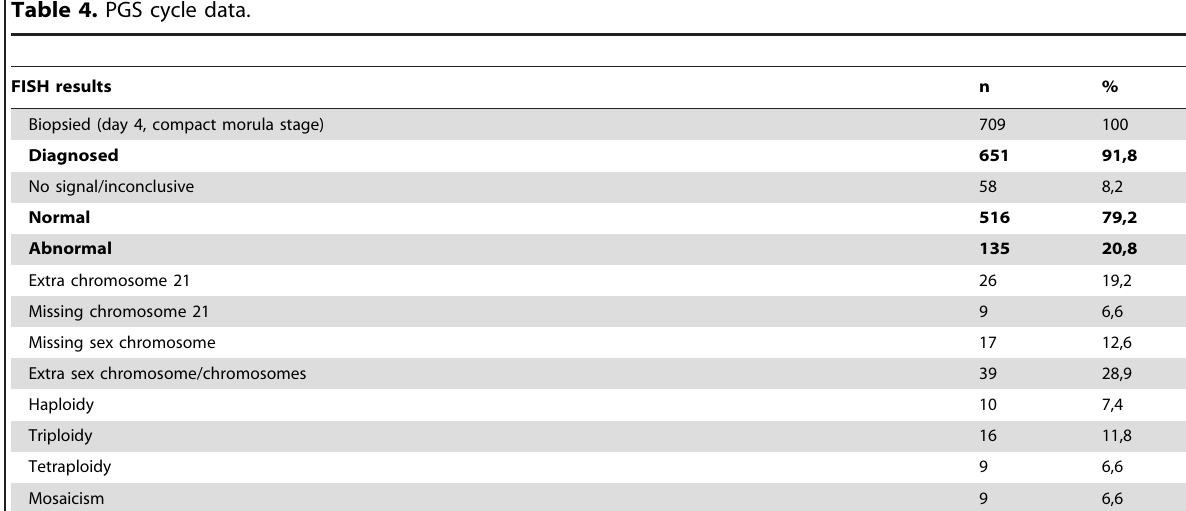
Table 4. PGS cycle